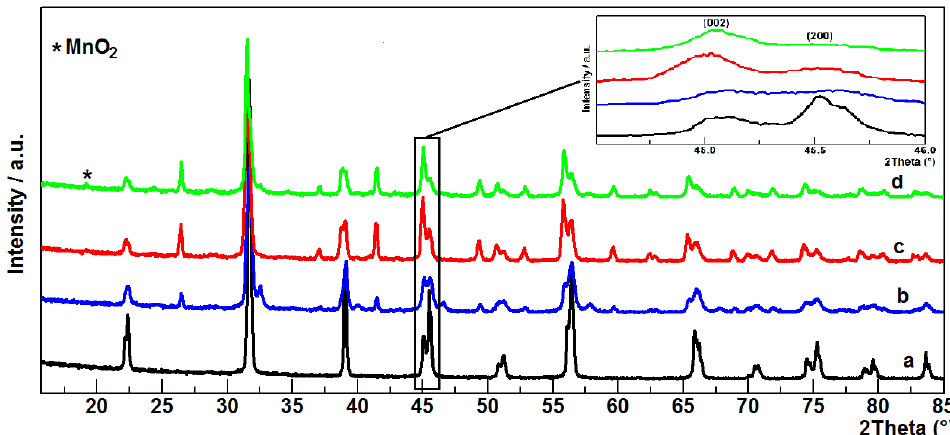
Figure 2. XRD patterns of BTO ( a ), BTO_1 ( b ), BTO_2 ( c ), and BTO_3 ( d ). Insert: enlargement of XRD patterns in the 2θ range of 44.5 – 46.0°.